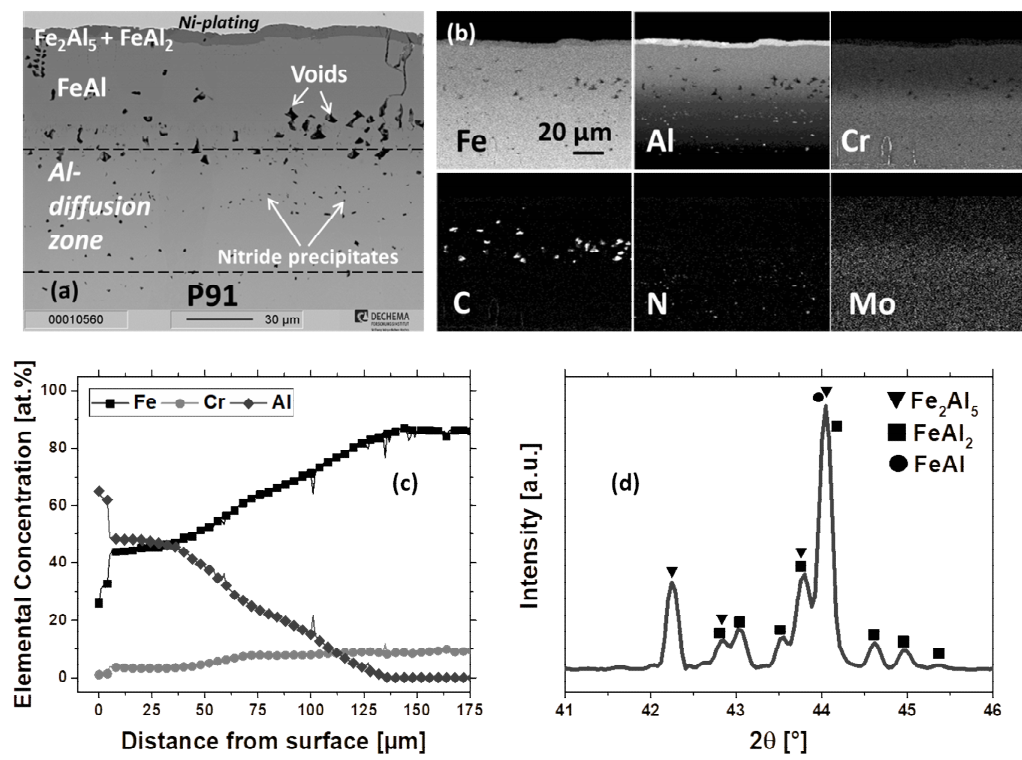
Figure 3. ( a ) Cross-sectional BSE-image, ( b ) elemental distribution maps and ( c ) quantitative line scans of Fe, Cr and Al as well as ( d ) XRD-pattern of aluminized